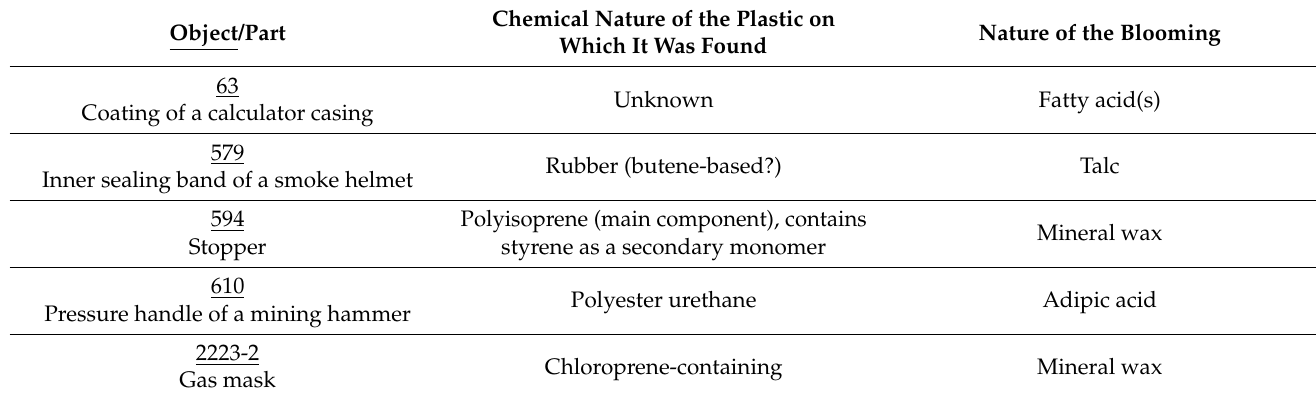
Table 12. Summary of the analytical results of the blooming samples and of the plastics on which they were found.